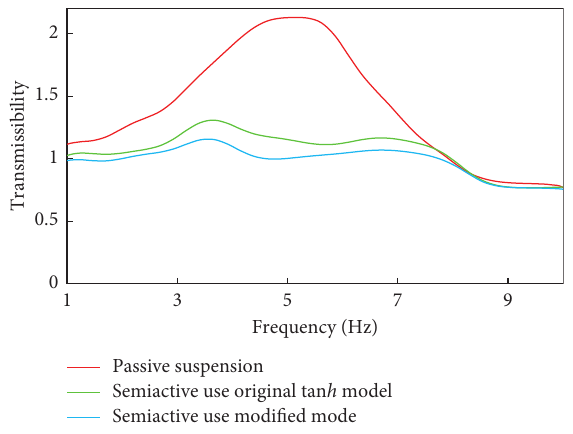
Figure 21: Comparison of vibration transmissibility of different models.